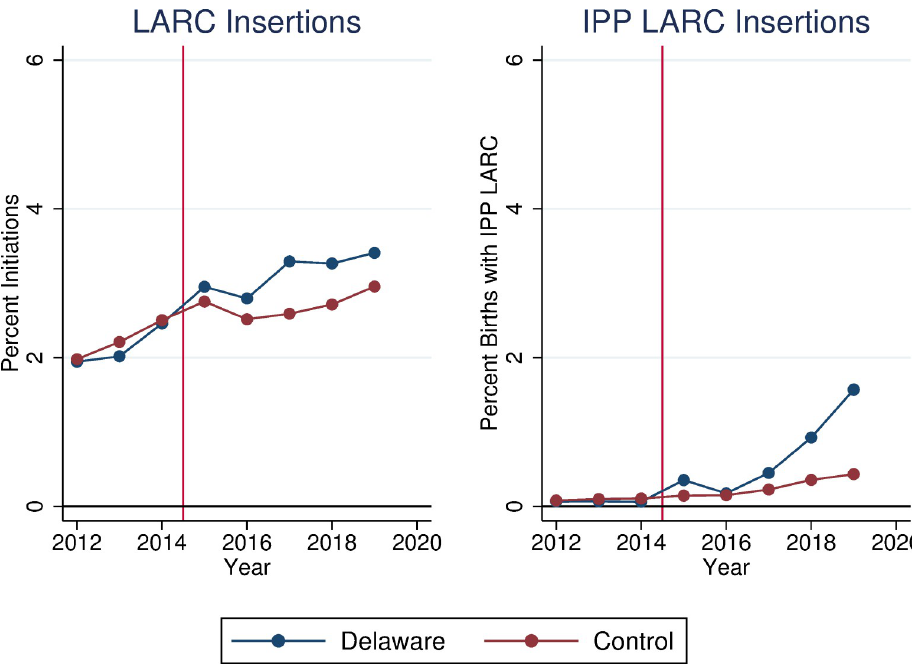
Fig 1. Average LARC insertion rates and IPP LARC insertion rates among women age 15–44 in delaware and control states. Source: IBM Marketscan Commercial Claims and Encounters Database (2012–2019). Notes: The rate reported in the left-hand panel each year is calculated as the number of women having a LARC device inserted in that year, divided by the total number of women enrolled in a plan in the Marketscan database. The rate reported in the right-hand panel is calculated as the number of births in a hospital where a LARC device was provided during the dates of hospitalization, divided by the total number of births occurring in a hospital recorded in the Marketscan database for each year.